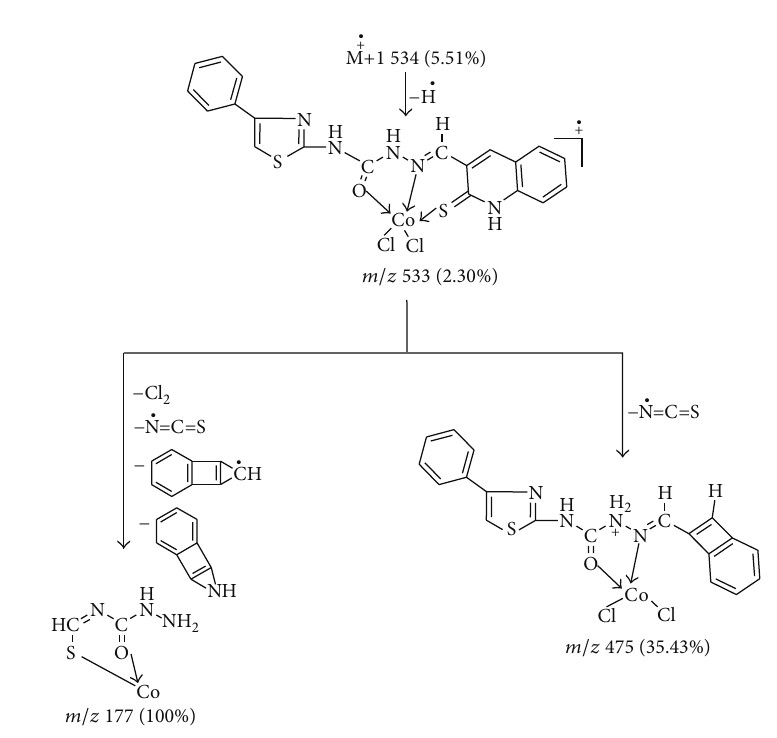
Figure 2: ESI mass spectrum of Ni(II) complex.